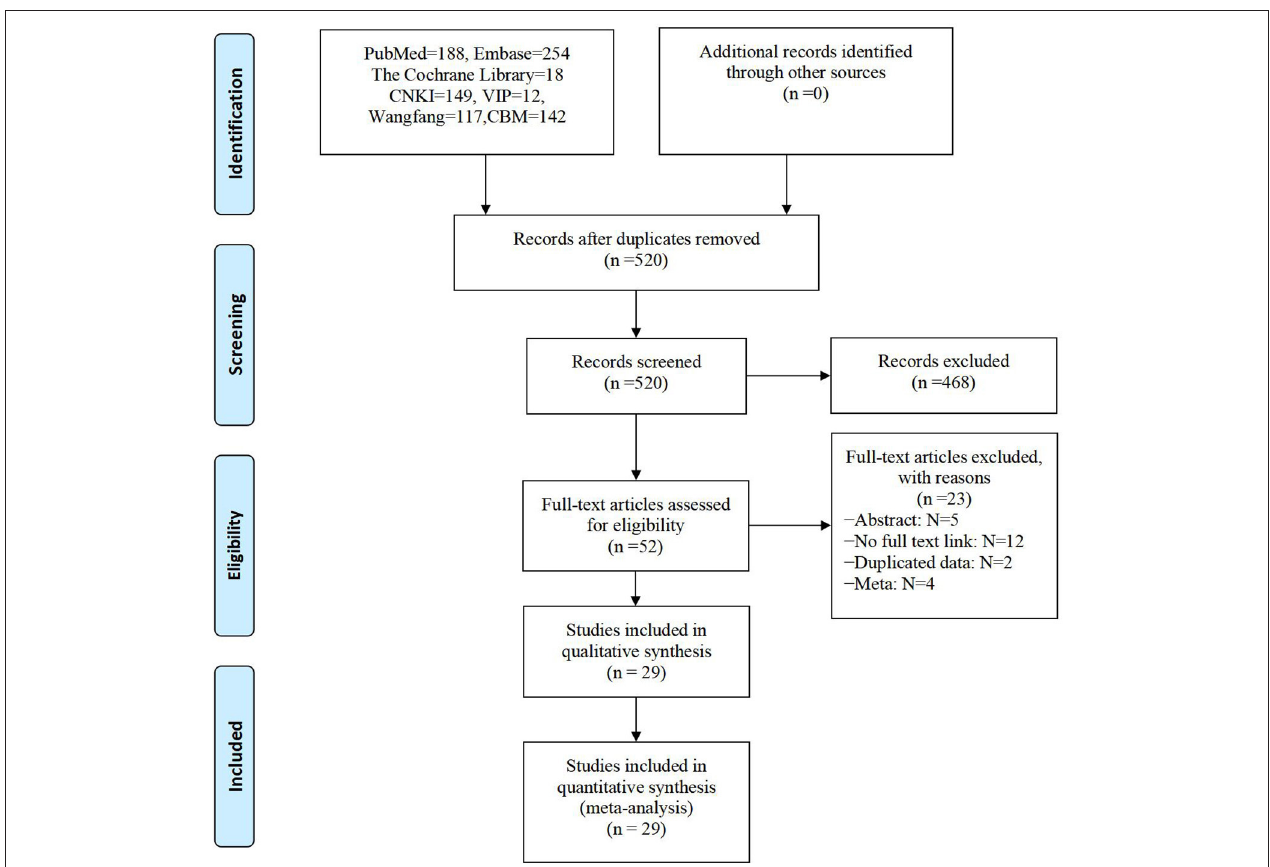
FIGURE 1 | Literature screening flow